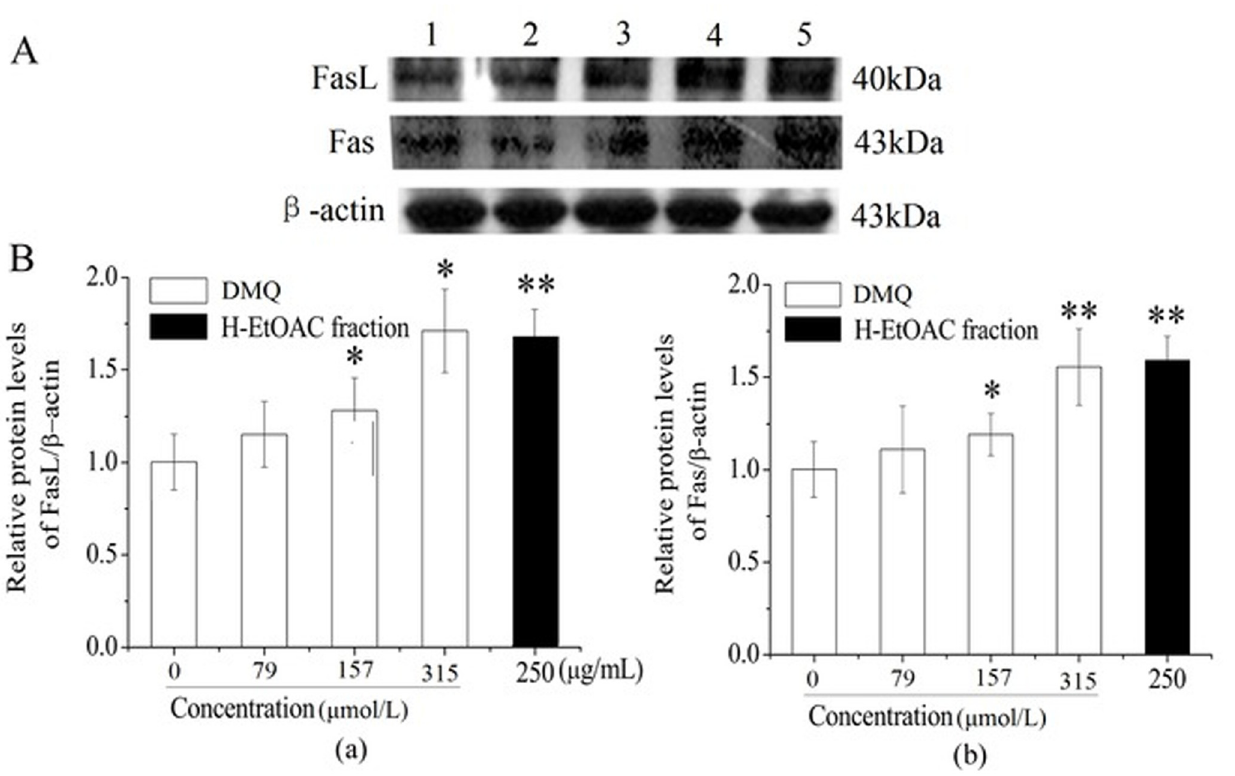
Fig 5. Death Receptor Pathway Related to HepG2 Cells Treated with DMQ and H-EtOAc Fraction. A. Western blot analysis of FasL and Fas. Lane 1: Control; Lane 2 – 4: 79, 157 and 315 μ mol/L of DMQ for 24 h, respectively; Lane 5: 250 μ g/mL of H-EtOAc fraction for 24 h. B. The protein expression levels of FasL (a) and Fas (b). Values are means ± SD of three independent experiments. * ( p < 0.05), ** ( p < 0.01) and *** ( p < 0.001) represented significant differences compared to the